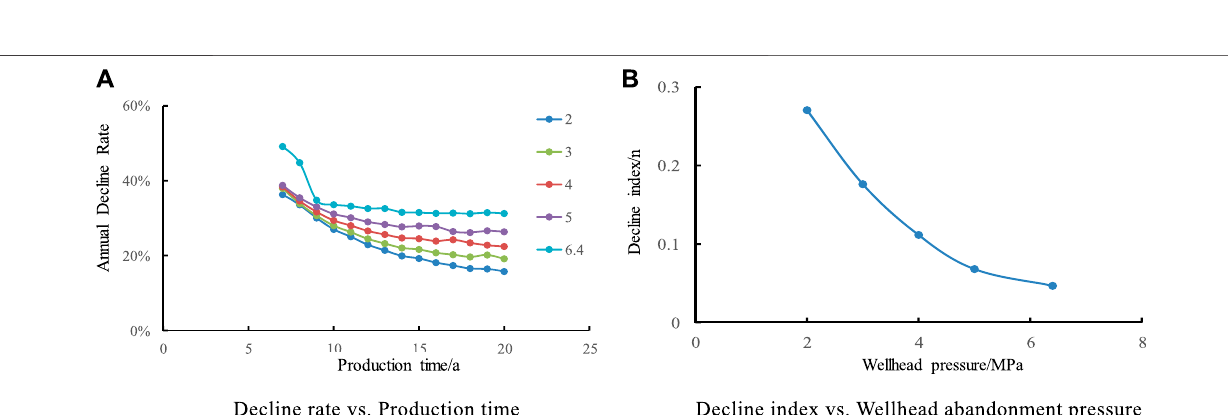
FIGURE 7| Effect ofconstant-gas-production on Annual Decline Rate and decline index. (A) Declinerate vs. Production time. (B) Decline index vs. Constant-gas- production-rate period.